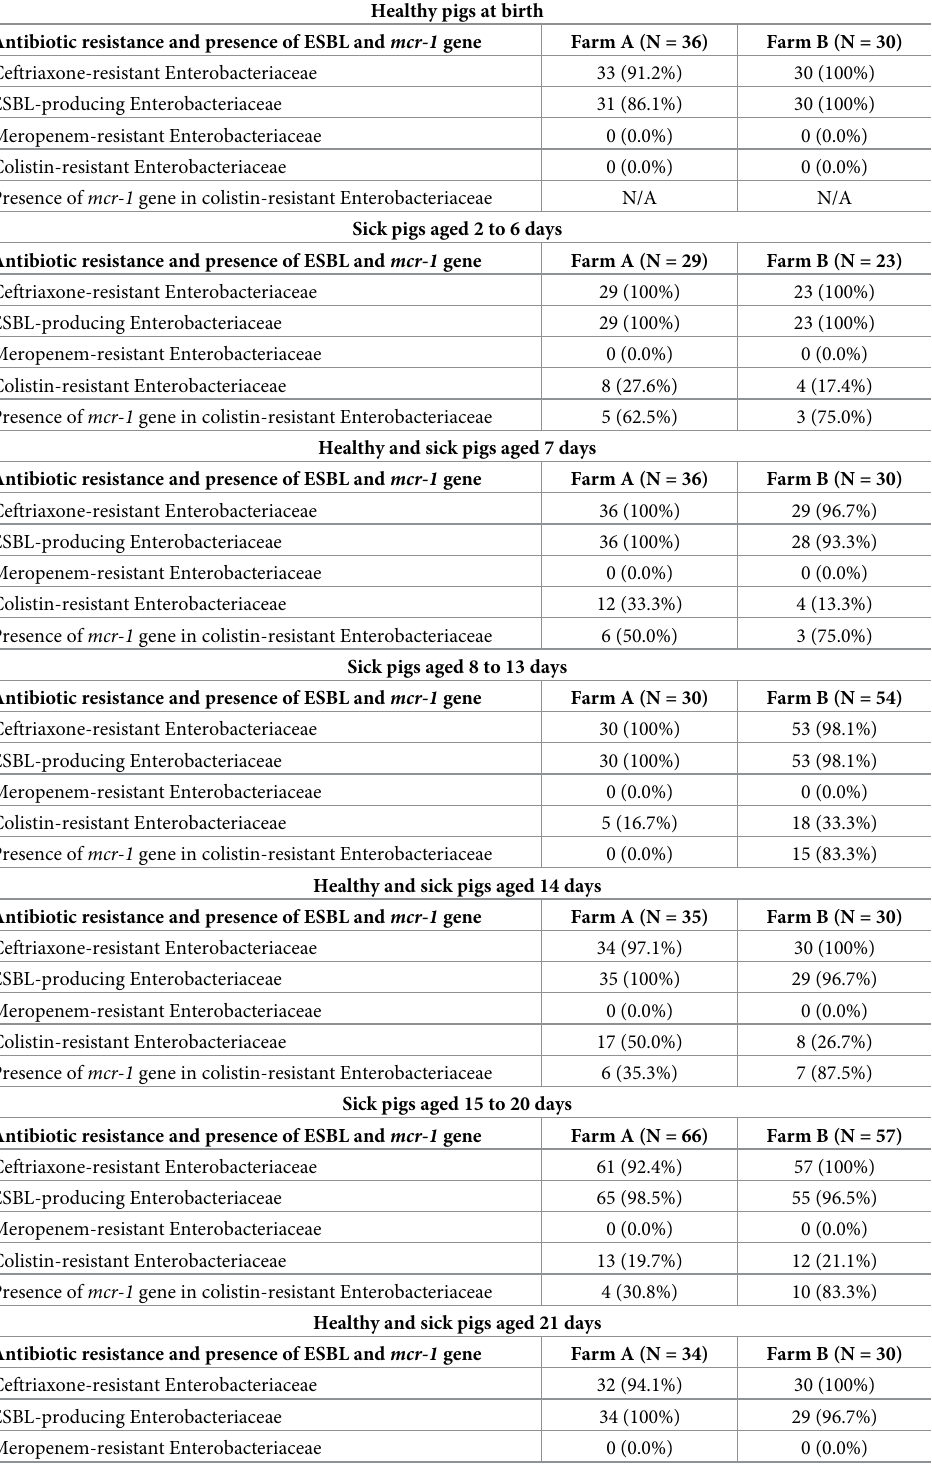
Table 2. Prevalence of resistance to ceftriaxone, meropenem, or colistin; of ESBL production; and, of the presence of the mcr-1 gene in Enterobacteriaceae isolated from pigs born to study sows. Healthy pigs at